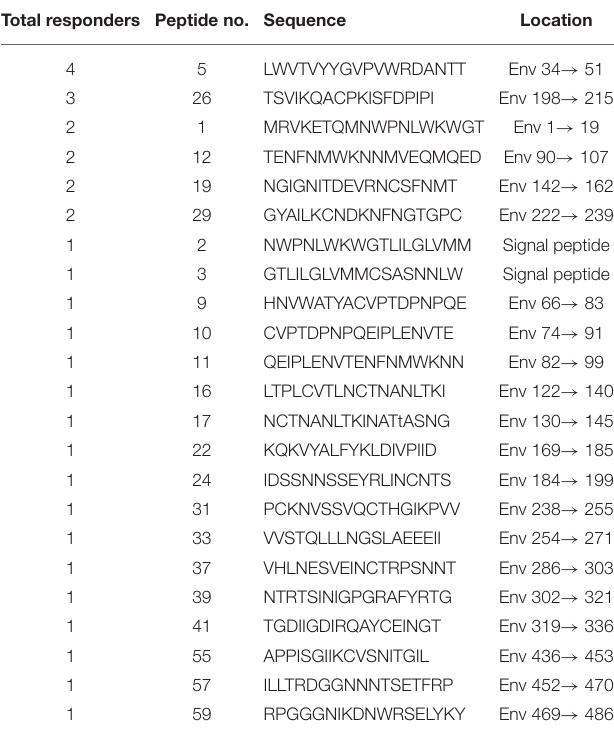
TABLE 3 | The percentage and magnitude of ADCC response to different peptide